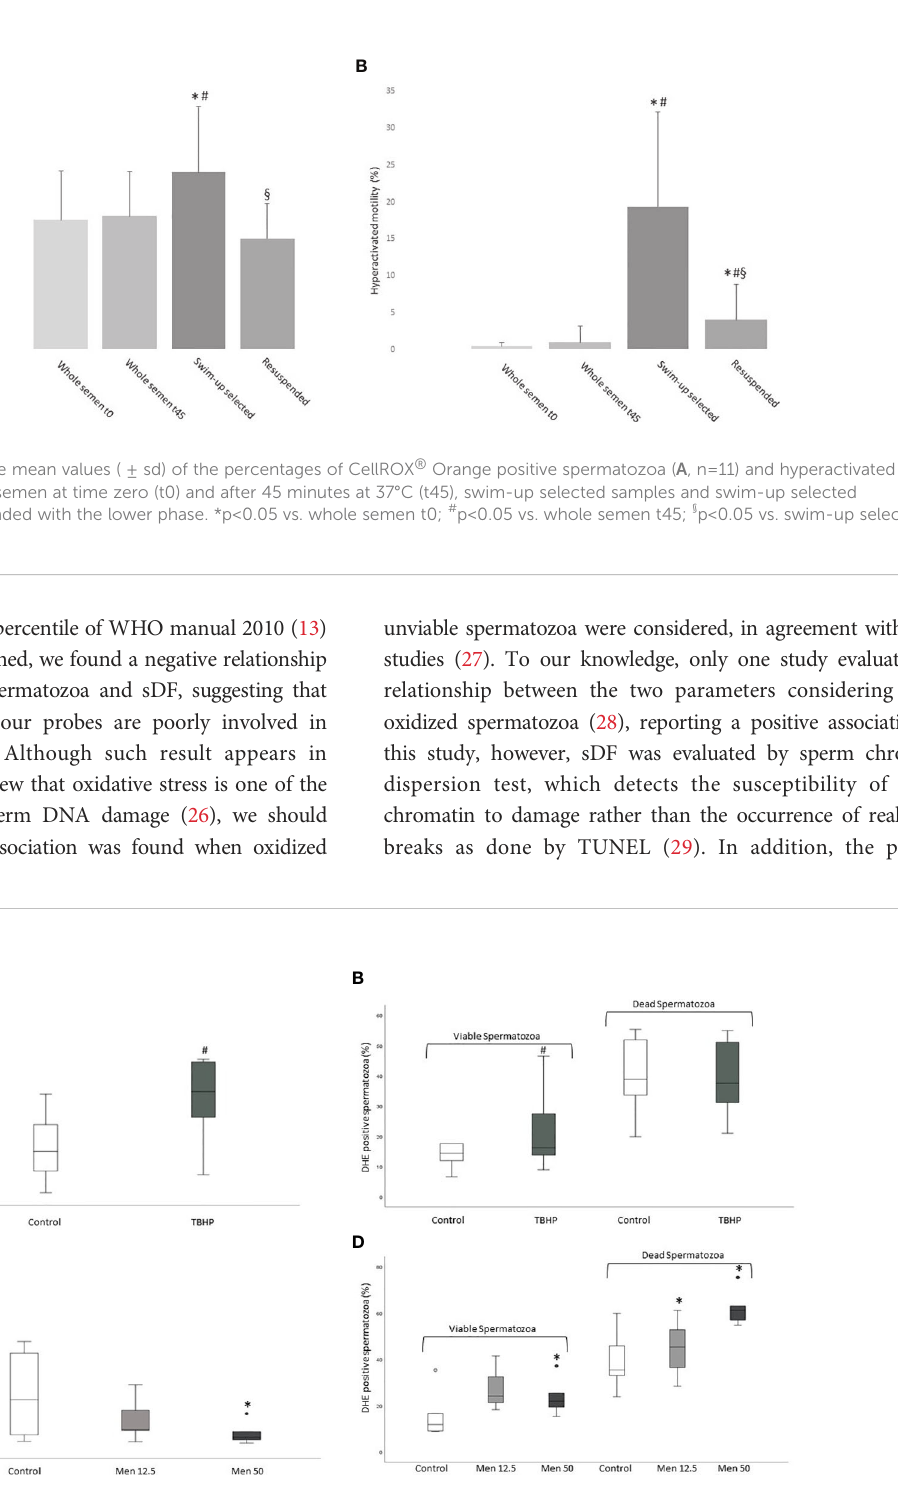
FIGURE 11 Box plots of the percentages of CellROX ® Orange ( A , only viable spermatozoa) and DHE ( B , viable and unviable spermatozoa) positive spermatozoa in control samples (incubated only with medium) and after incubation for 30 minutes with TBHP (1mM) and box plots of the percentages of CellROX ® Orange ( C , only viable spermatozoa) and DHE positive spermatozoa ( D , viable and unviable spermatozoa) in control samples (incubated only with medium) and after incubation for 30 minutes with Menadione (12.5 and 50 µM). # p<0.01 vs. CTRL; *p<0.05 vs.